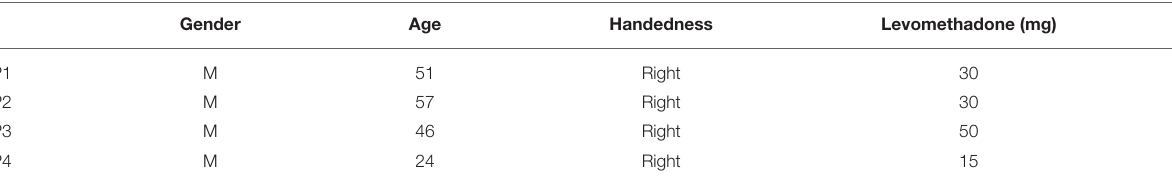
TABLE 1 | Demographic data of the patients.